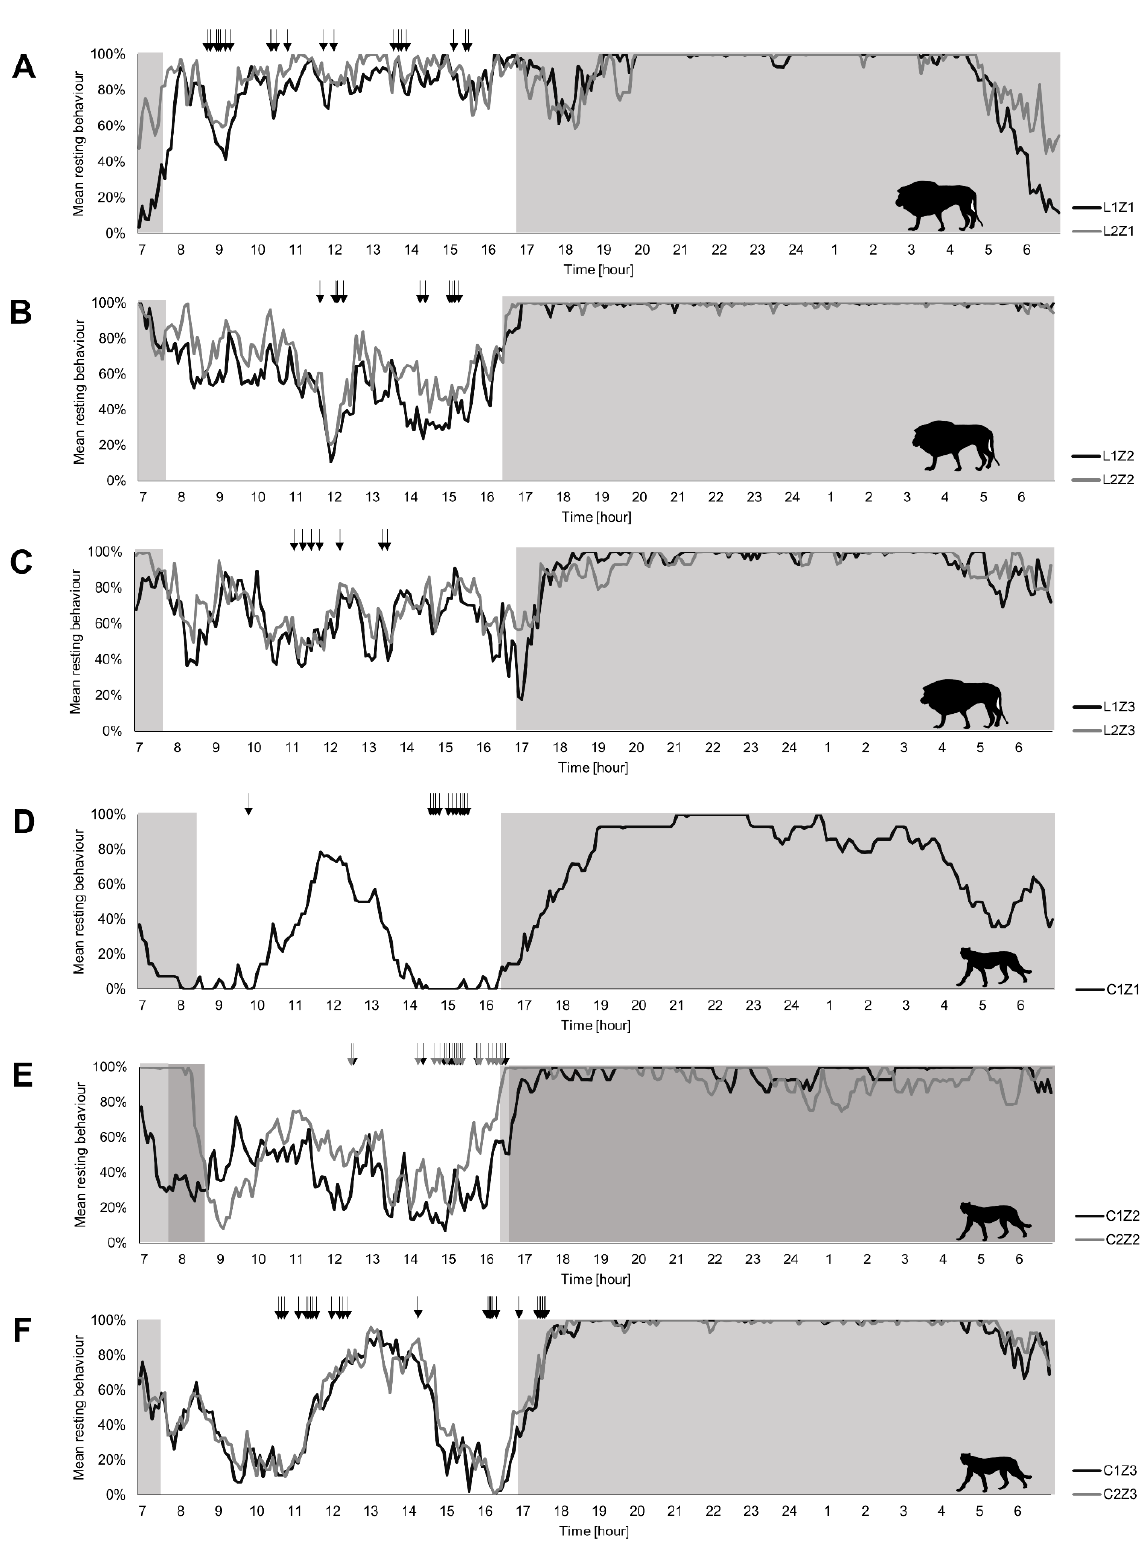
Figure 2. Time course of resting behaviour over 24 h: Resting behaviour of lions ( A – C ) and cheetahs ( D – F ) over a study period of 14 days (7a.m.–7p.m.) and nights (7p.m.–7a.m.). For identification purposes, individuals were categorised as follows: species/individual/zoo. Arrows mark feeding events throughout the observation period. Grey areas show dark periods. In zoo3 ( E ) dark periods vary between individuals due to different observation periods.